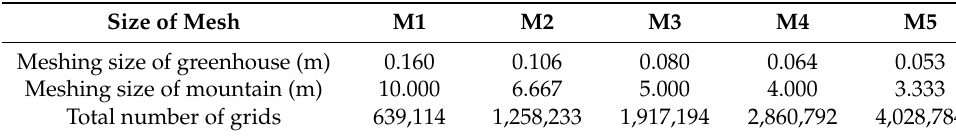
Table 5. Number and dimensions of the grids.